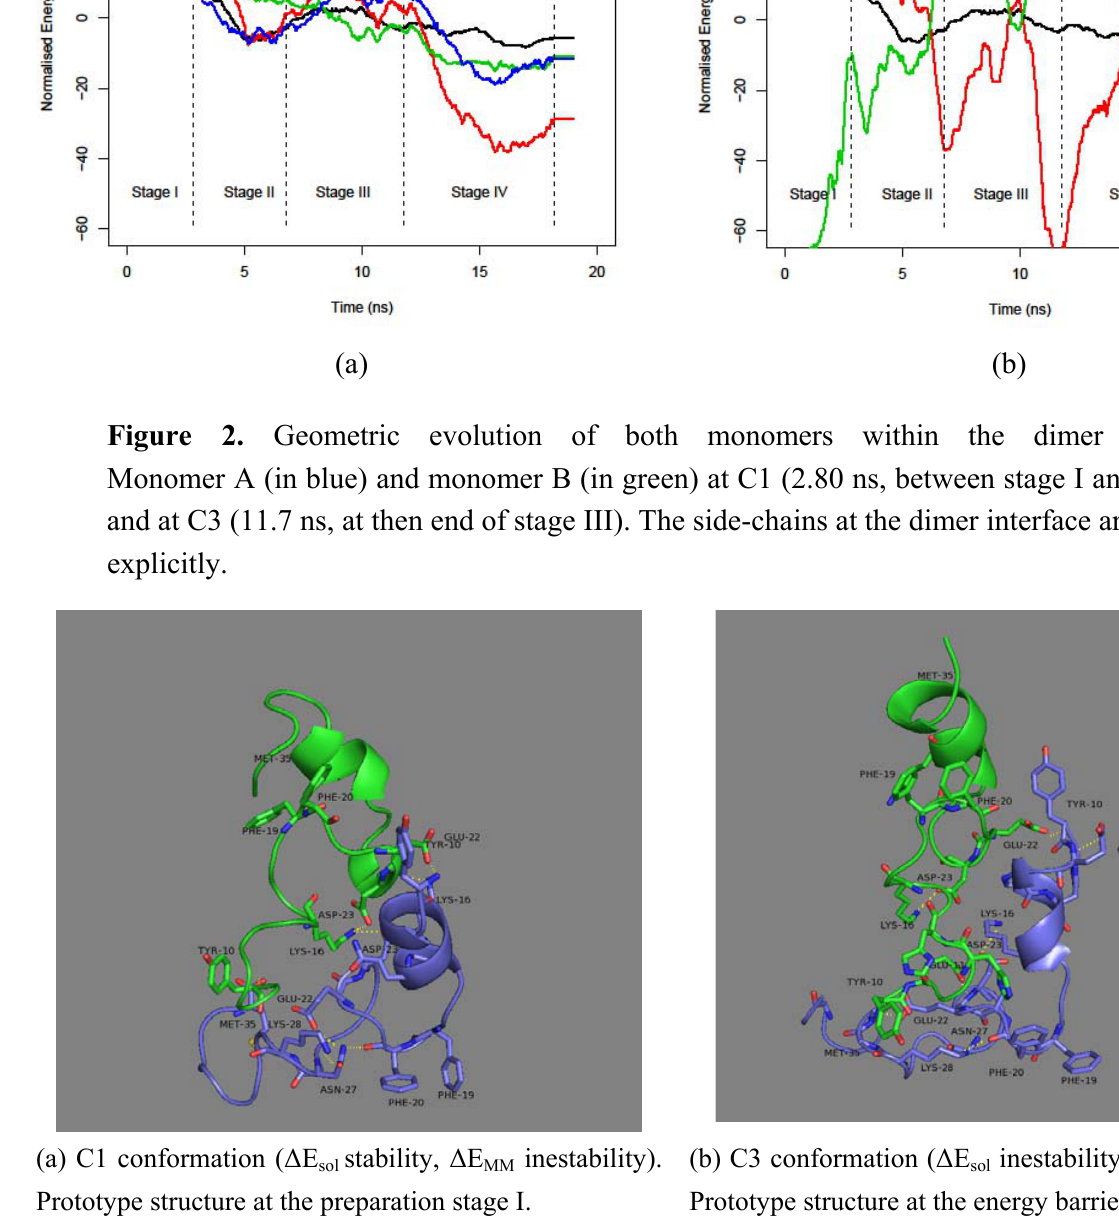
decomposition according to Δ E bind